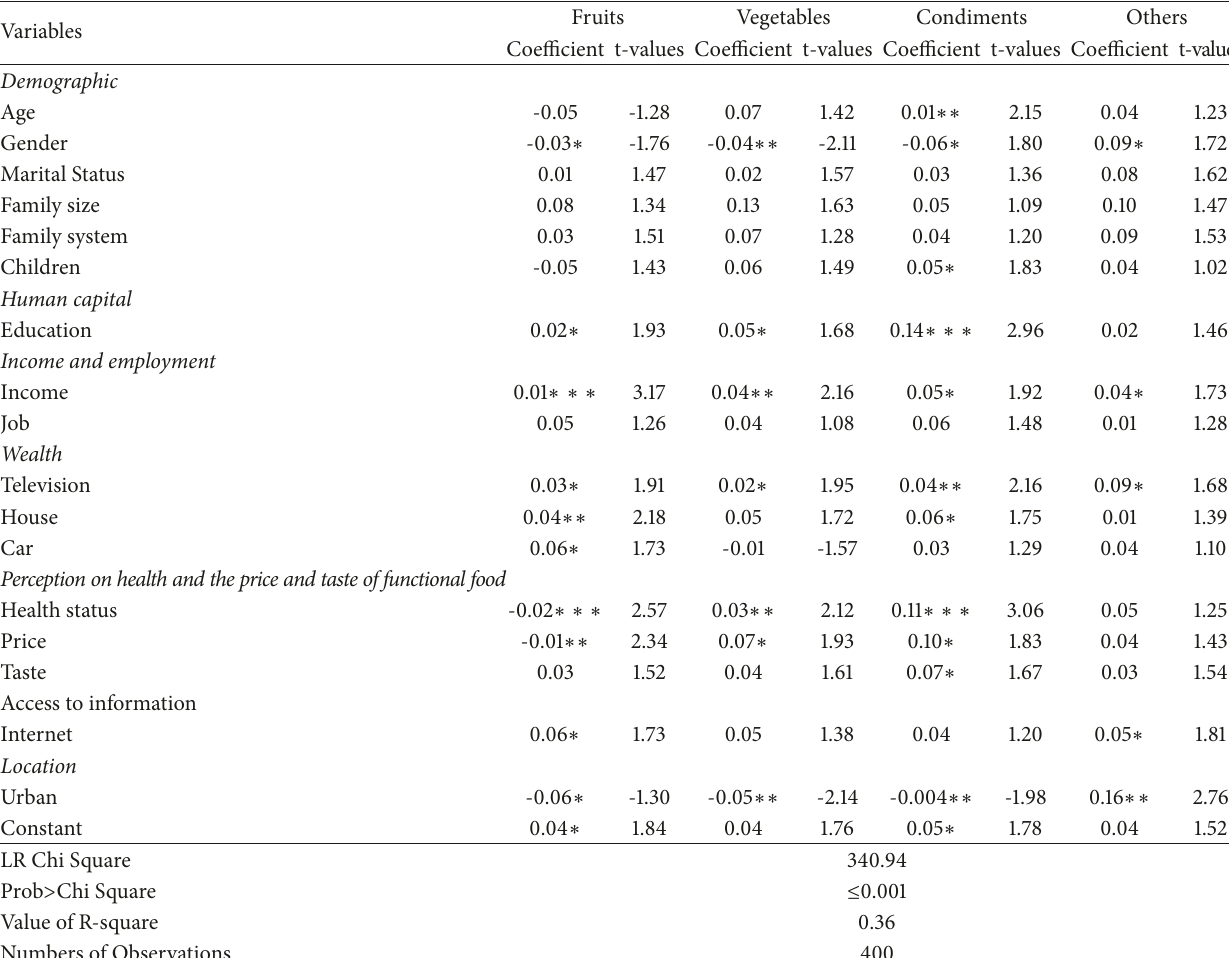
Table 5: Preferred source of functional food (multivariate probit